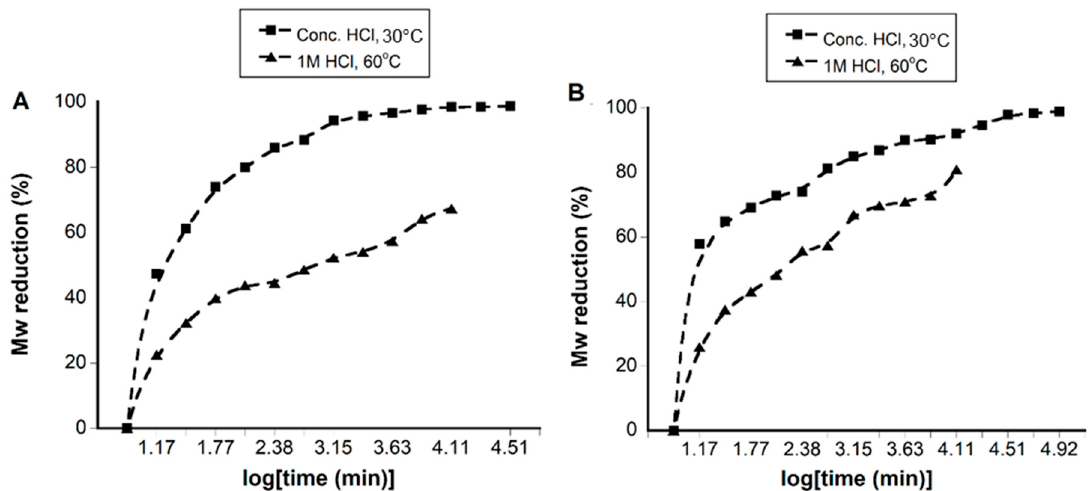
Figure 2. Figure showing the M w reduction with time for TMC ( A ) and chitosan ( B ) using concentrated (12 M) HCl (30 ◦ C) and 1 M HCl (60 ◦ C). The % reduction was calculated using the equation, % reduction = Mw p × 100/Mw i ; where Mw p = Mw obtained at different time points and Mw i = initial Mw for chitosan and TMC.